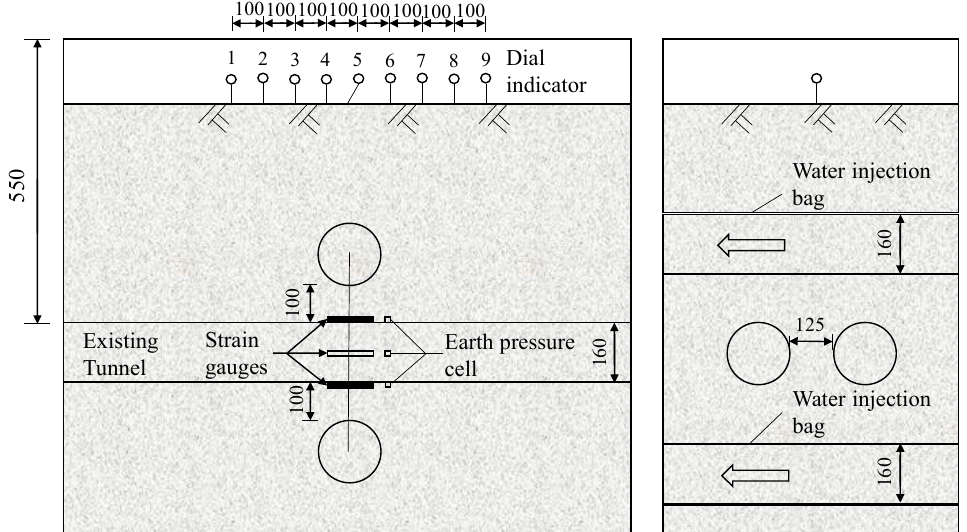
Figure 2. Complex crossing testing conditions (unit: mm).